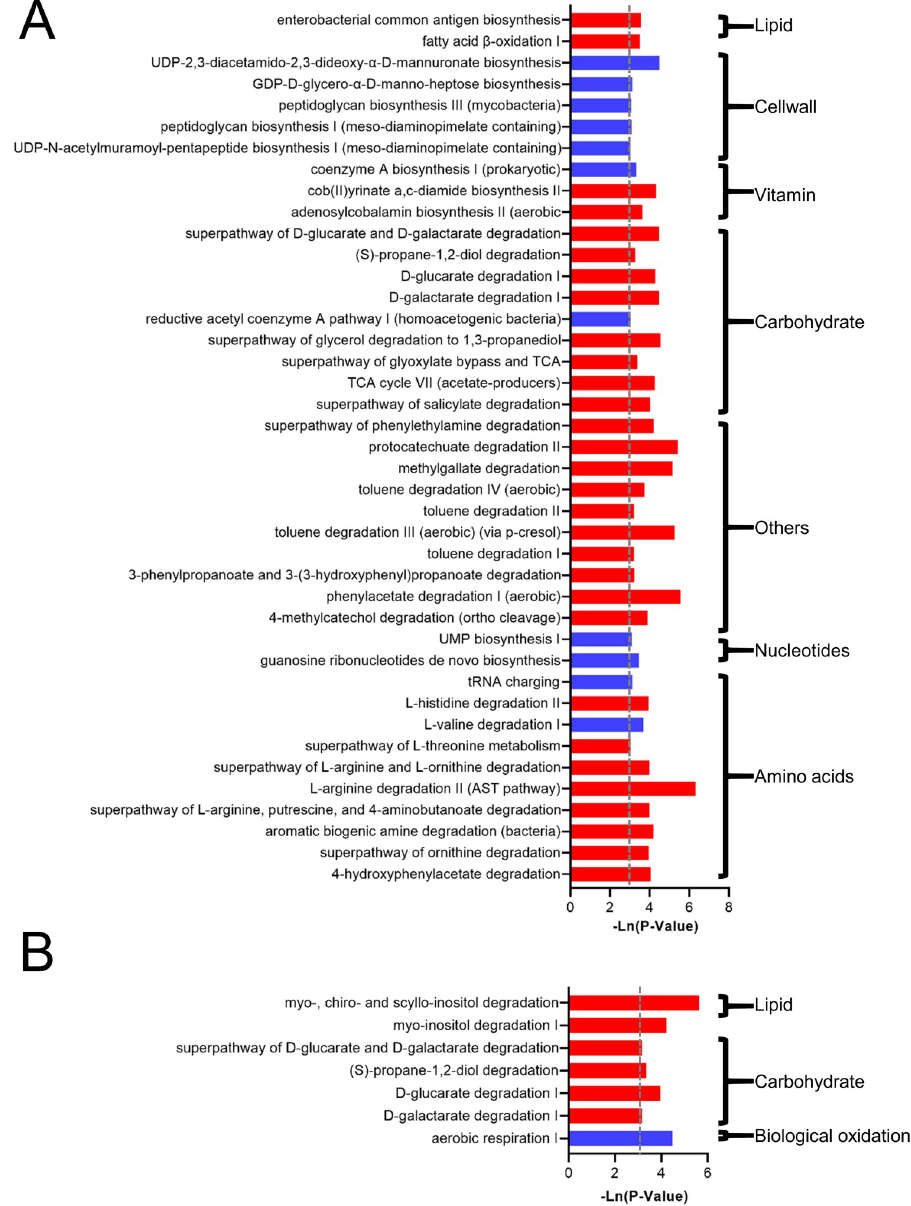
Fig 6. The effect of cat ownership on the microbiota’s function of normal weight and overweight individuals. The significant effect of cat ownership on microbial metabolism pathways, (A) normal-weight and (B) overweight